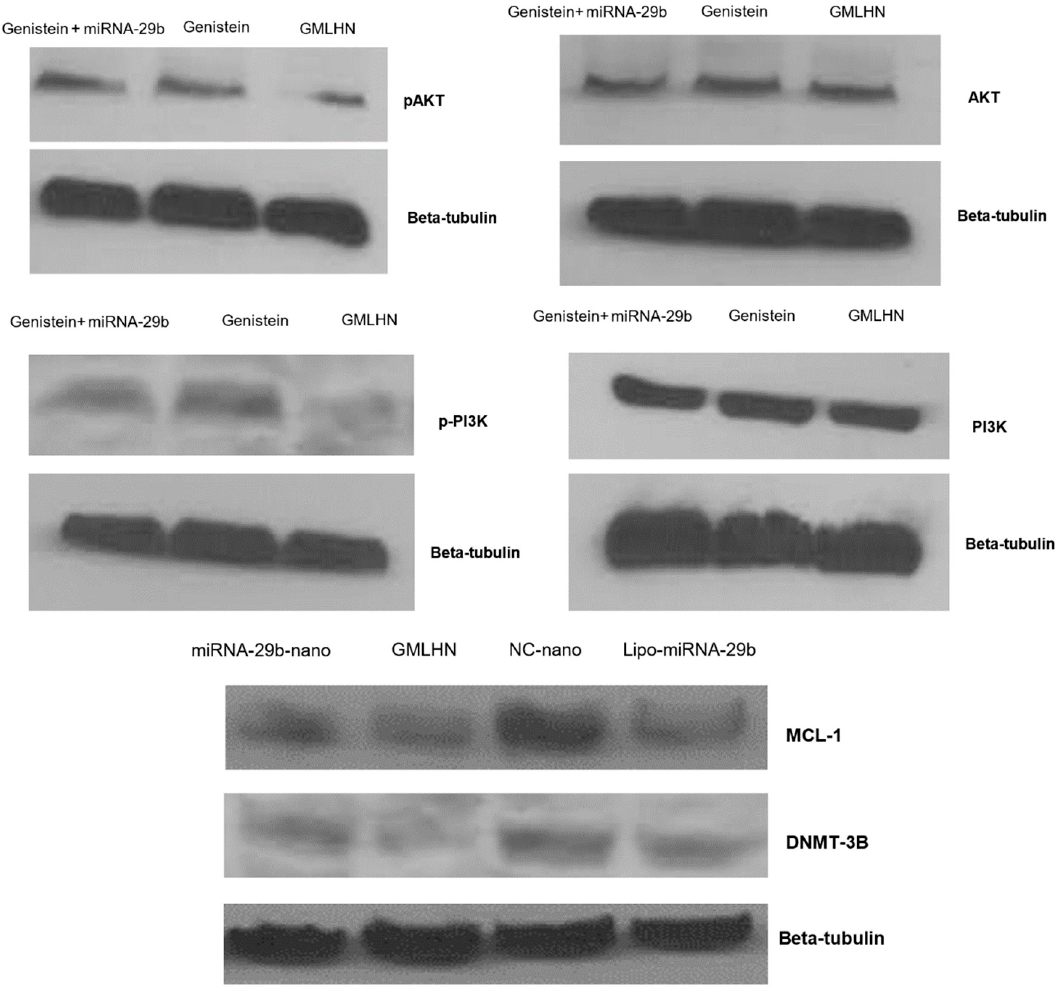
Figure 3. Downregulation of oncogenes in A549 cells. Western blot analysis was used to probe the e ff ect of MUC 1-aptamer functionalized GMLHN on the expression of A. pAKT, B. AKT, C. p-PI3K, D. PI3K and E. both MCL-1 and DNMT-2B. NC-nano represents negative control miRNA-loaded hybrid nanoparticles, lipo-miRNA-29b represents lipofectamine-transfected